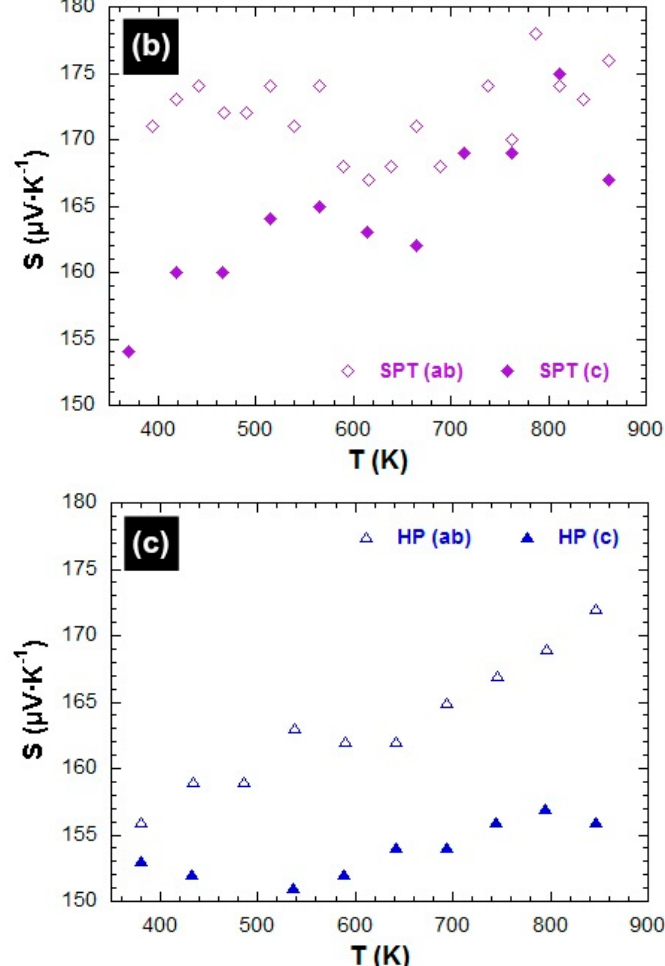
Figure 6. Temperature dependence of the Seebeck coefficient measured parallel (S c ) and perpendicular (S ab ) to the mean c*-axis ( a ) SPS, ( b ) SPT, and ( c ) HP stacks. (S ab ) to the mean c*-axis ( a ) SPS, ( b ) SPT, and ( c ) HP